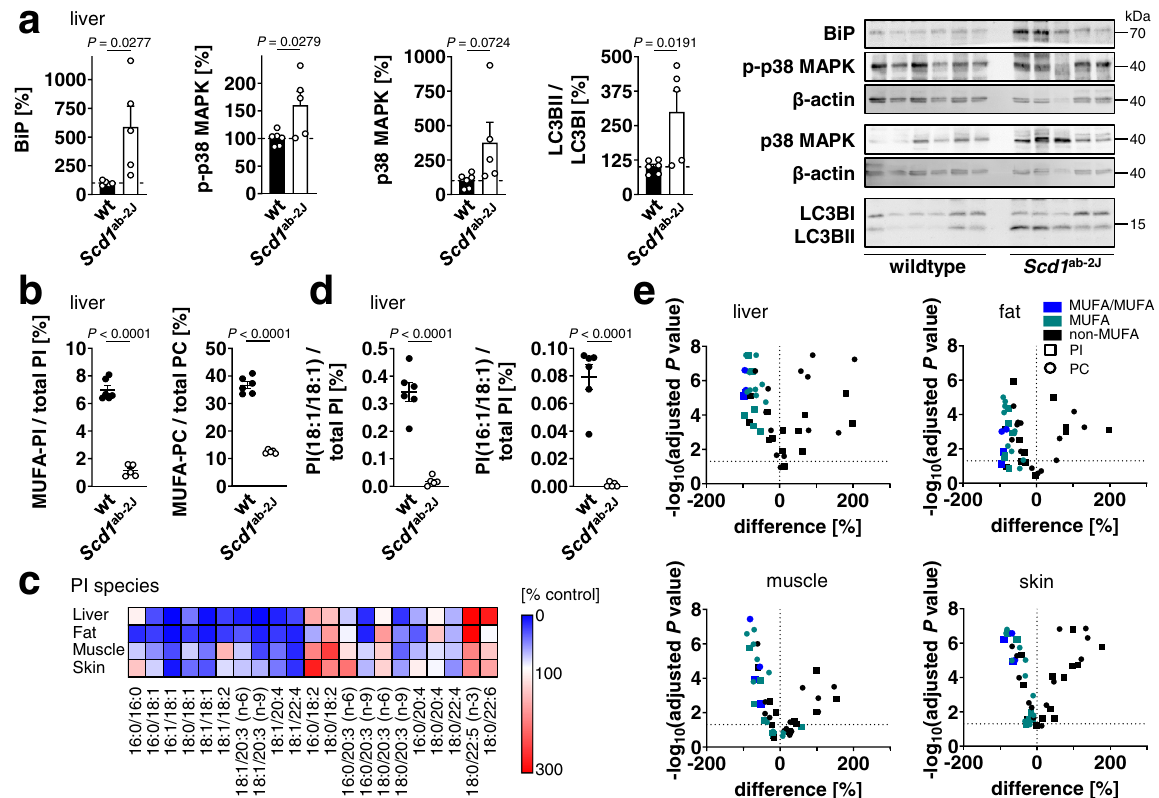
Fig. 5 MUFA-containing PI species indicate stress in mice with Scd1 defect. Liver, white abdominal fat, hind leg skeletal muscle, and skin were obtained from wildtype mice (wt) and mice homozygous for the Scd1 ab-2J allele ( Scd1 ab-2J ). a Protein expression of BiP and p38 MAPK, p38 MAPK phosphorylation, and the ratio of LC3BII/LC3BI protein levels in liver. b Hepatic proportion of MUFAs in PI and PC; MUFAs: 16:1, 18:1 (LTR P = 0.00000008, 0.00000003). c Heatmap showing the changes in the PI pro fi le of liver, fat, skeletal muscle, and skin from Scd1 ab-2J mice as compared to wt mice. Data are given as percentage of the relative PI abundance in wt tissues. d Hepatic proportion of PI(18:1/18:1) and PI(16:1/18:1) (LTR P = 0.00001, 0.00003). e Volcano plots highlighting PI and PC species that are regulated in murine tissues from Scd1 ab-2J mice relative to wt mice. Comparisons show the mean difference of percentage changes and the negative log10(adjusted P value). Adjusted P values given vs. vehicle control; two-tailed multiple unpaired student t tests with correction for multiple comparisons using a two-stage linear step-up procedure by Benjamini, Krieger, and Yekutieli (false discovery rate 5%). Phospholipids containing two MUFAs ( “ MUFA/MUFA ” ) or one MUFA in combination with SFA or PUFA ( “ MUFA ” ) are indicated by color. Mean ( c , e ) or mean + s.e.m. and single data ( a , b , d ) from n = 6 (wt) and n = 5 ( Scd1 ab-2J ; a for BiP, wt) mice. P values as indicated; two-tailed unpaired student t